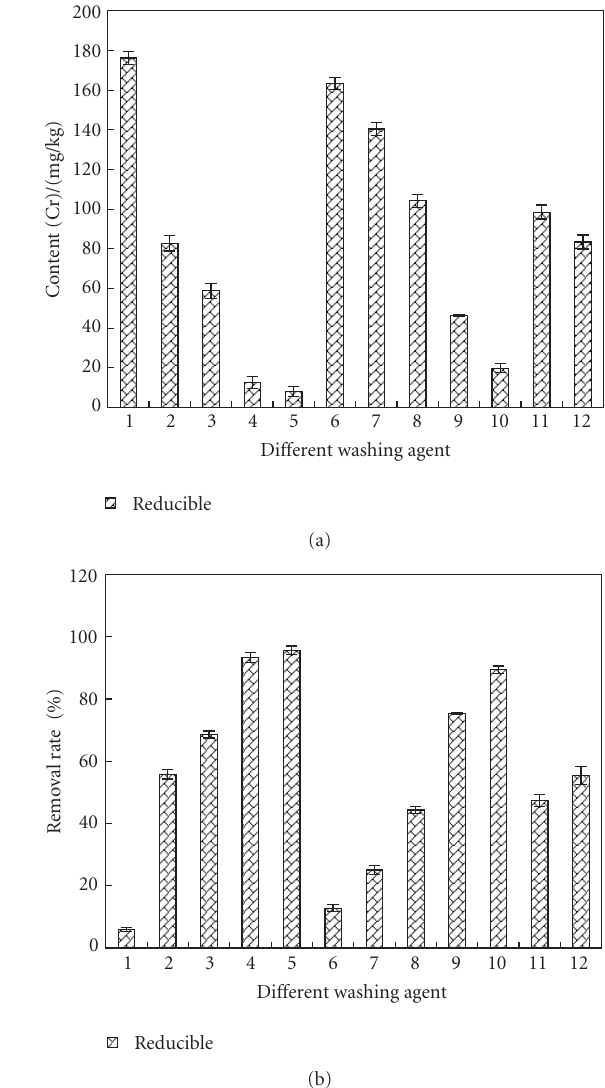
Figure 8: Removal e ff ect of acid soluble Cr by di ff erent washing agents. Washing agent: 1—water; 2—0.05 mol/L EDTA-Na 2 ; 3— 0.1mol/L EDTA-Na 2 ; 4—0.1 mol/L citric acid; 5—0.5 mol/L citric acid; 6—0.1 mol/L oxalic acid; 7—0.5 mol/L oxalic acid; 8— 0.1mol/L HCl; 9—0.5 mol/L HCl; 10—1 mol/L HCl; 11—0.1 mol/L acetic acid; 12—0.5 mol/L acetic acid.